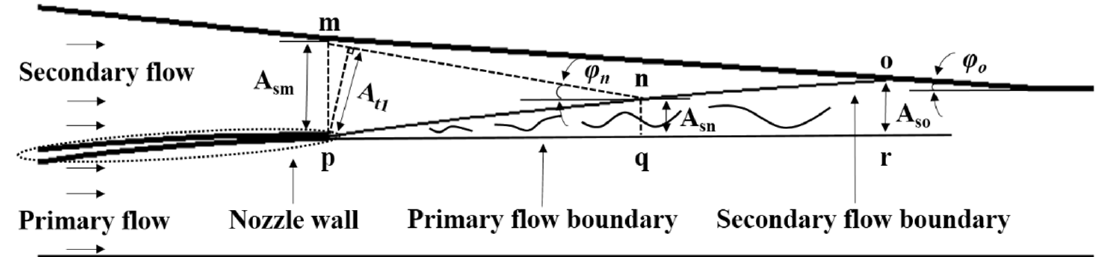
Figure 15. Schematic diagram of flow mixing on different φ .